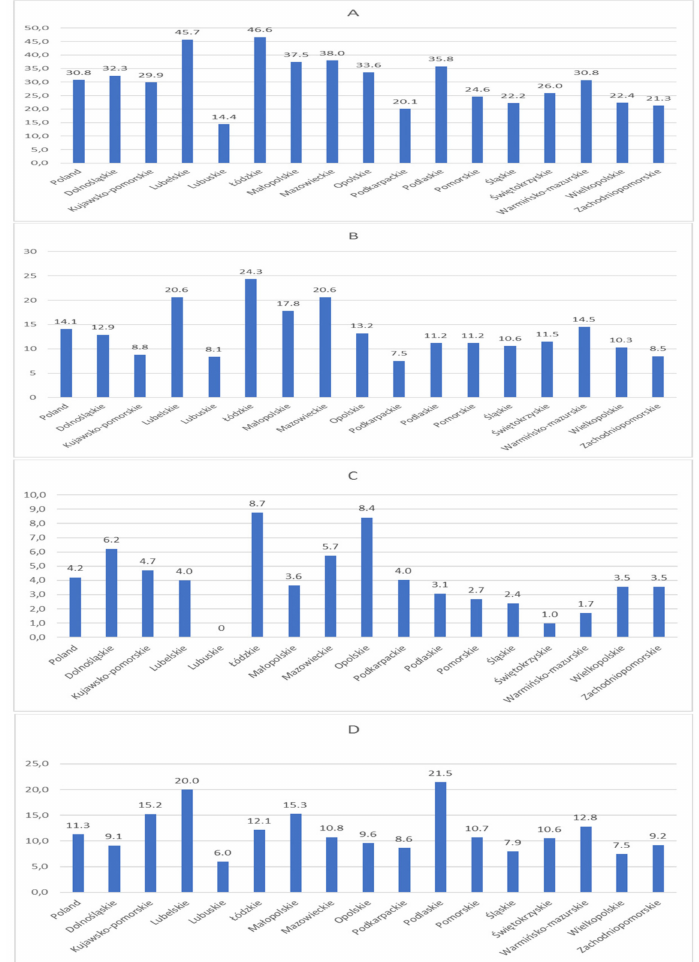
Figure A1. Geographical distribution of patients with pulmonary arterial hypertension ( A ) and its most frequent subgroups including idiopathic pulmonary arterial hypertension ( B ), pulmonary arterial hypertension associated with connective tissue disease ( C ) and pulmonary arterial hypertension associated with congenital heart disease ( D ).